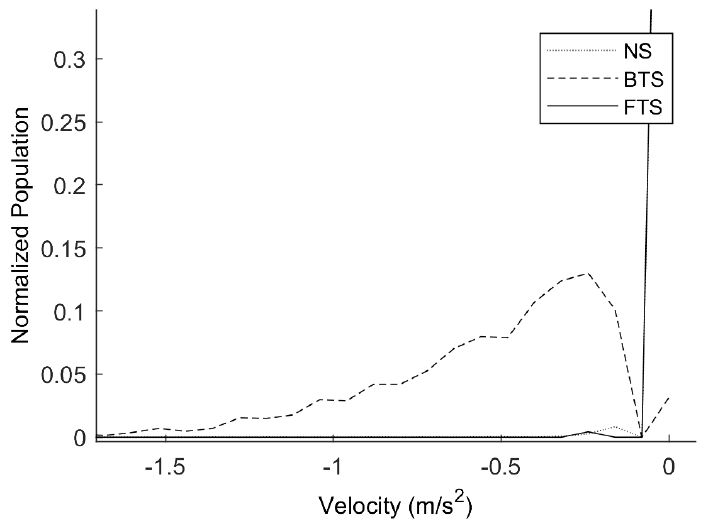
Figure 8. Sample histogram of a feature, negative AP velocity peaks before toe off.